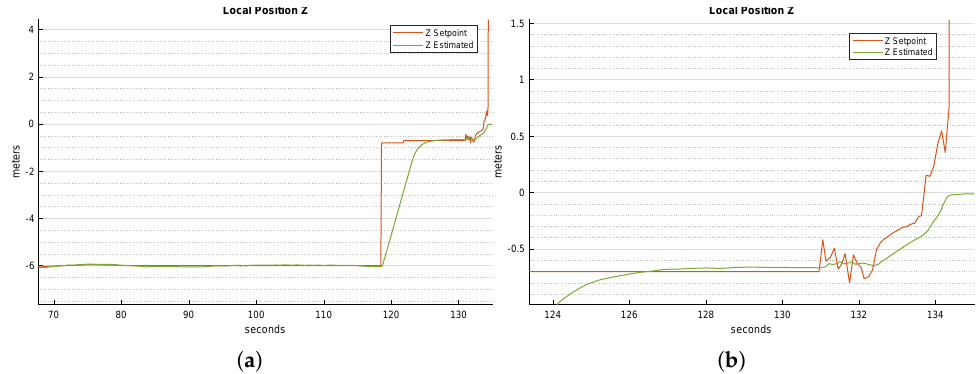
Figure 10. Time-wise behavior of the absolute z position and setpoint: ( a ) overall simulation; ( b ) a zoom of the compensation state. Notice that at t = 134 s, a high setpoint was generated to force the UAV to freefall on top of the landing pad.